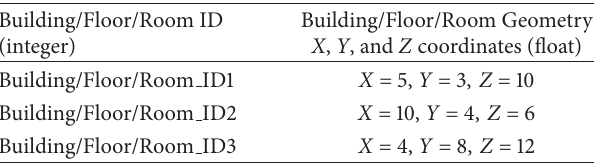
Table 2: Output table of the Building Floor Plan